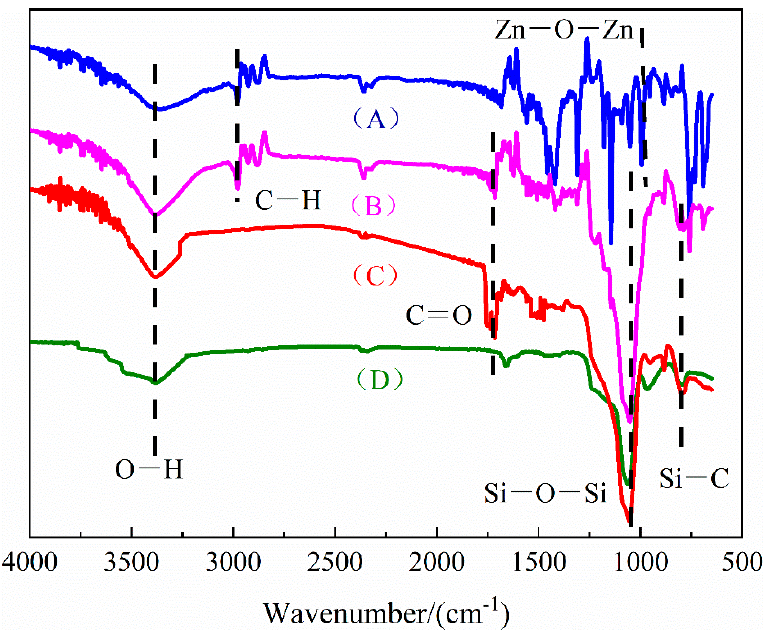
Figure 1. FT-IR spectra in range of 4000–500 cm − 1 . ( A ) Zeolitic imidazolate framework-8 (ZIF-8, blue line); ( B ) Core–shell nanocomposite prepared by ZIF-8 immobilized ADH, LDH, and MSN-NAD (ZIF@ADH/NAD-MSN/LDH, purple line); ( C ) Carboxyl modified silica nanoparticles (MSN-COOH, red line); ( D ) Mesoporous silica nanoparticles (MSN, green line).